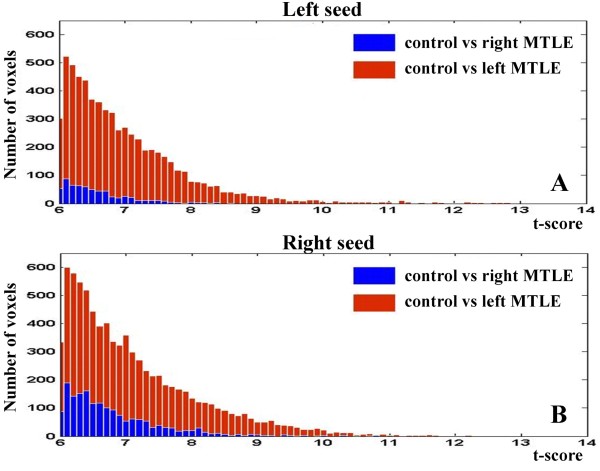
Histogram of the Functional Connectivity Maps: intergroup comparisons. A - Left seed: Blue line - control group versus right MTLE. The sum of the voxels was 630. Red line - control group versus left MTLE. The sum of the voxels was 6494. B - Right seed: Blue line - control group versus right MTLE. The sum of the voxels was 1765. Red line - control group versus left MTLE. The sum of the voxels was 8232.